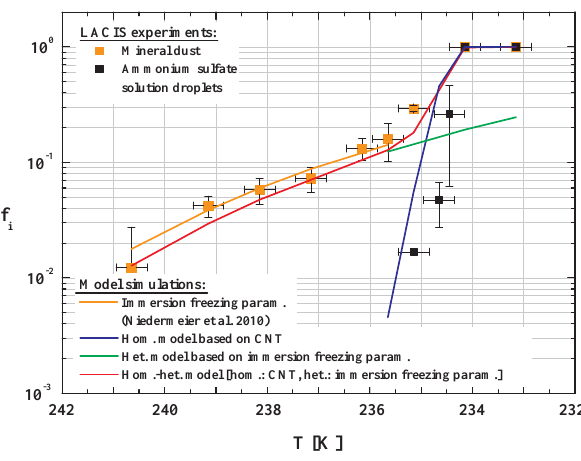
Fig. 16. Comparison of LACIS experiments (freezing of droplets Fig. 6. Comparison of LACIS experiments (freezing of droplets containing 300 nmmineraldustparticlesactingasIN:orangecubes containing 300nm mineral dust particles acting as IN: orange cubes and freezing of highly dilutes ammonium sulfate solution droplets: and freezing of highly dilutes ammonium sulfate solution droplets: black cubes) with Fluent/FPM model simulation results. The blue curve presents homogeneous ice nucleation according to CNT. black cubes) with Fluent/FPM model simulation results. The blue Model simulations taking both freezing modes into account, homo- curve presents homogeneous ice nucleation according to CNT. geneous and heterogeneous, based on CNT are given for different contact angels and total IN surfaces ( θ = 90 ◦ , s p = 2 . 810 − 13 m 2 : Model simulations taking both freezing modes into account, homo- grey dashed dashed dotted curve; θ = 90 ◦ , s p = 1 . 110 − 13 m 2 : geneous and heterogeneous, based on CNT are given for different grey dotted curve; θ = 105 ◦ , s p = 2 . 810 − 13 m 2 : grey dashed contact angels and total IN surfaces ( θ = 90 ◦ , s p = 2 . 810 − 13 m 2 : curve). grey dashed dashed dotted curve; θ = 90 ◦ , s p = 1 . 110 − 13 m 2 : grey dotted curve; θ = 105 ◦ , s p = 2 . 810 − 13 m 2 : grey dashed curve).